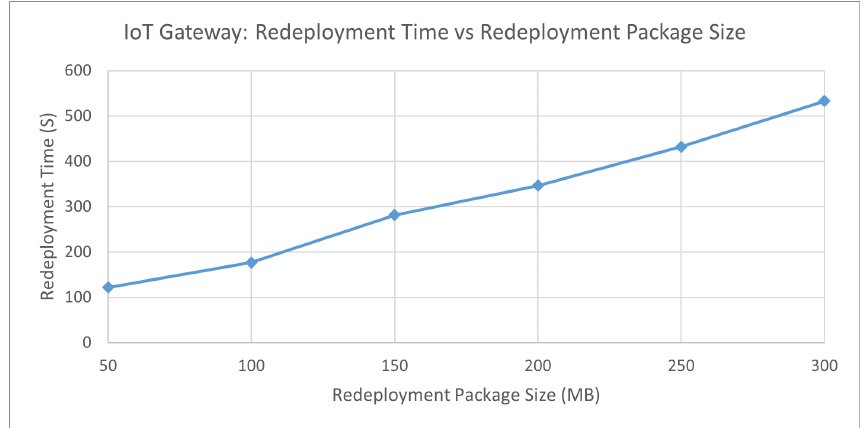
Figure 9. Redeployment Time vs. Redeployment Package Size.